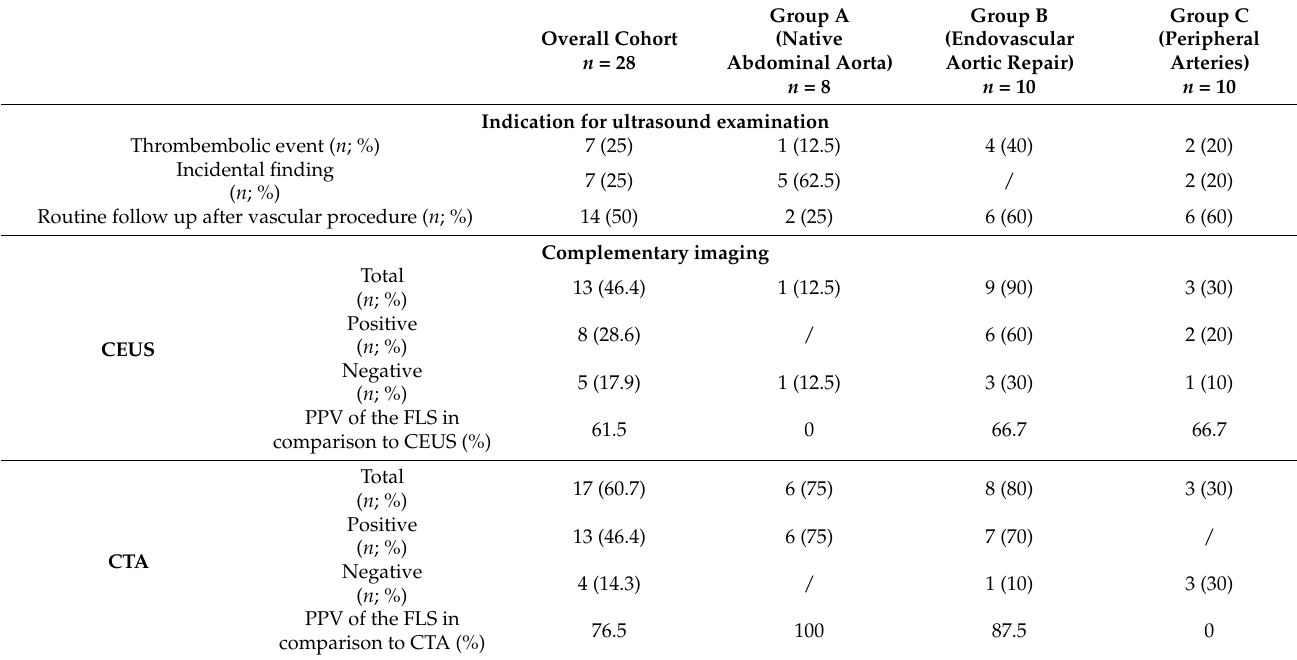
Table 2. Characteristics of the overall cohort and certain